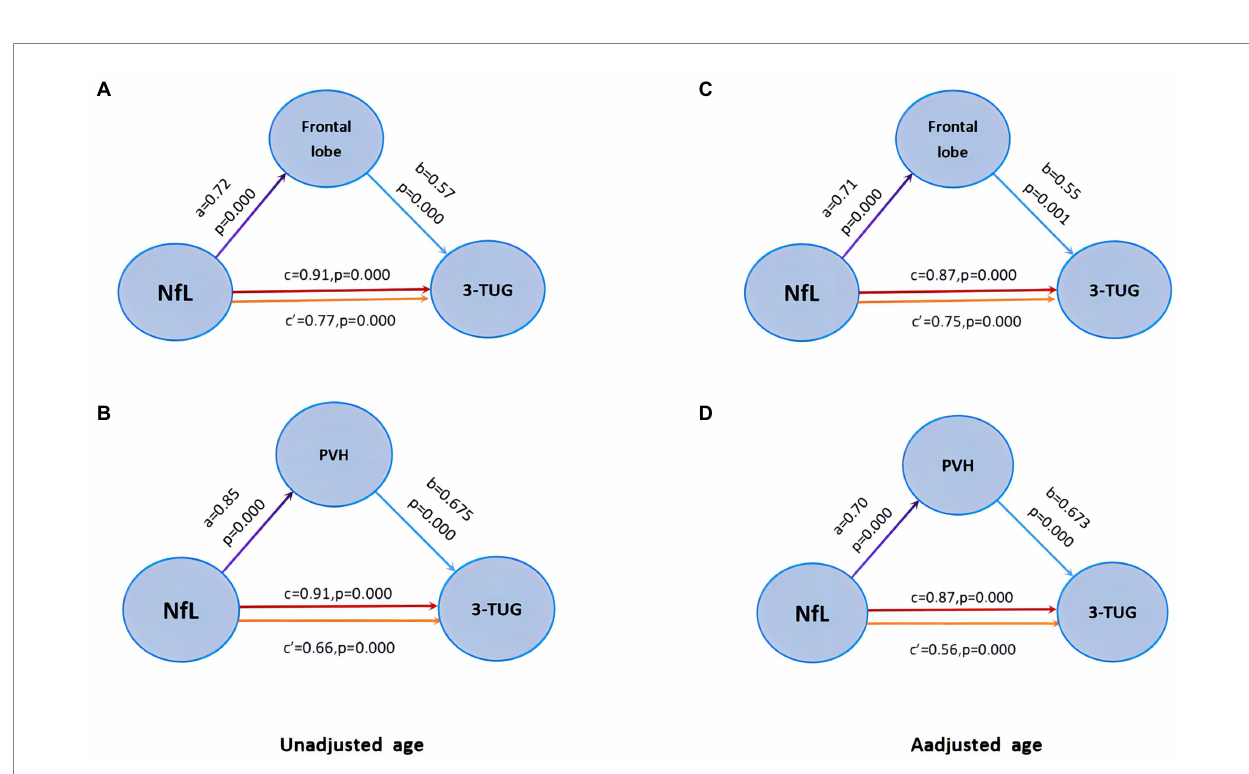
FIGURE 5 Mediation effect model. (A–B) Frontal WMH and PVH partially mediate the relationship between Nfl and gait disorder. (C–D) There was still a statistical difference after adjusting for age.